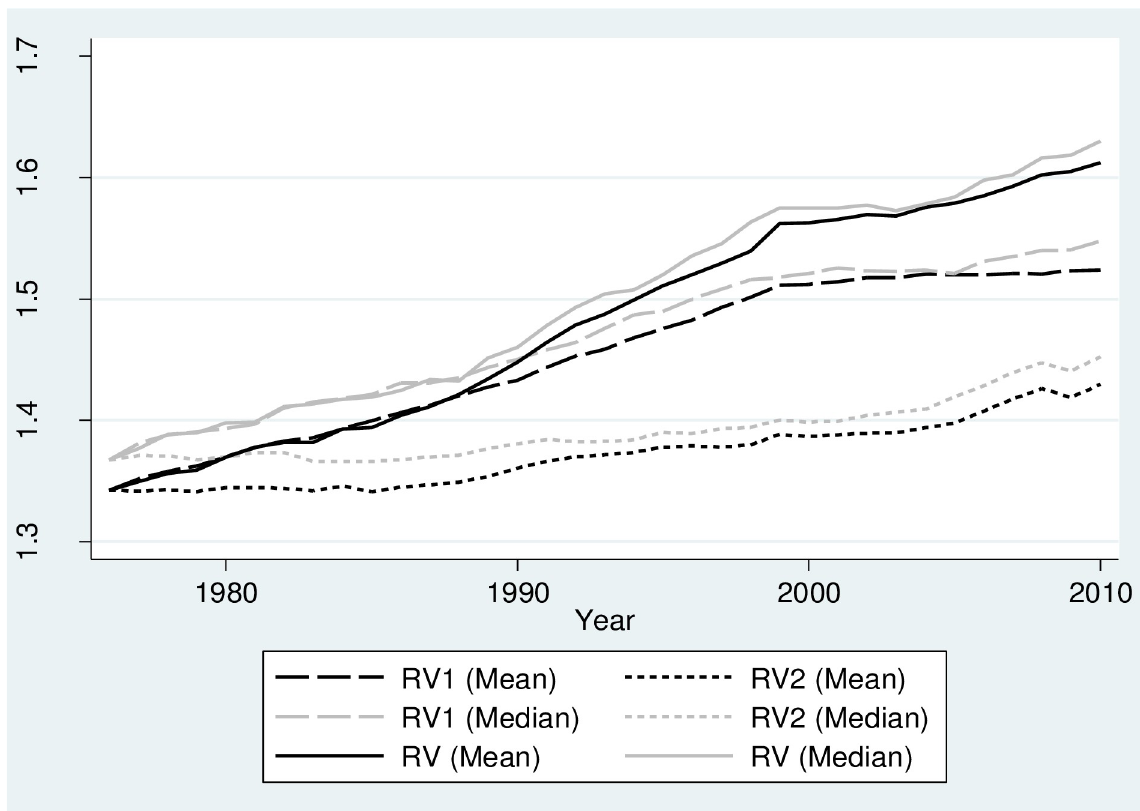
Fig 7. Relative importance of Pg and Hg in the growth of RV over time. Notes: RV1: Related variety measured by keeping Pg constant at the values at 1976. RV2: Related variety measured by keeping Hg constant at the values at 1976. Dashed lines represent median values of RV across